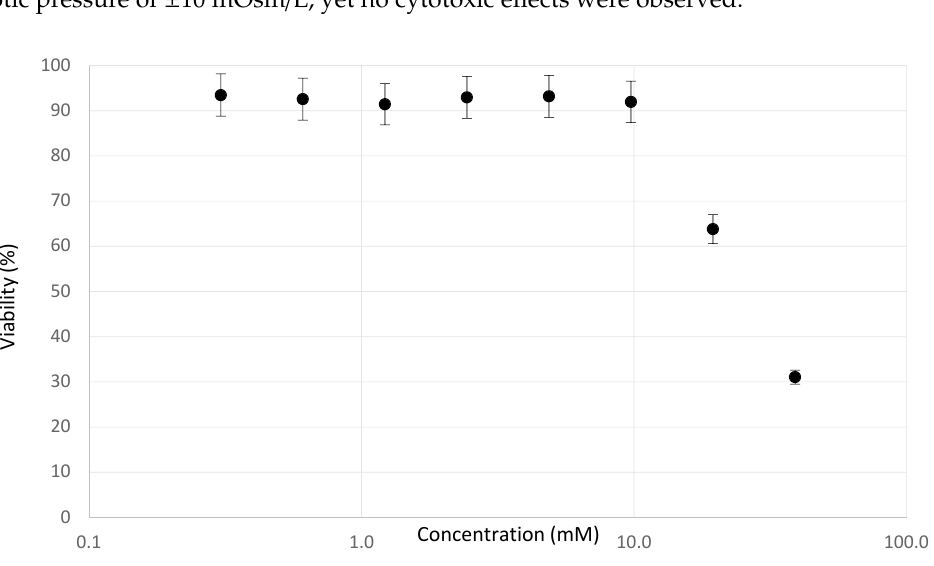
Figure 1. Averaged viability curve for the neutral red uptake (NRU)-assay upon daily exposure to sodium saccharin for a period of 72 h. Cytotoxicity is observed from 10 mM onwards, which is equal to an osmotic pressure of ± 20 mOsm /